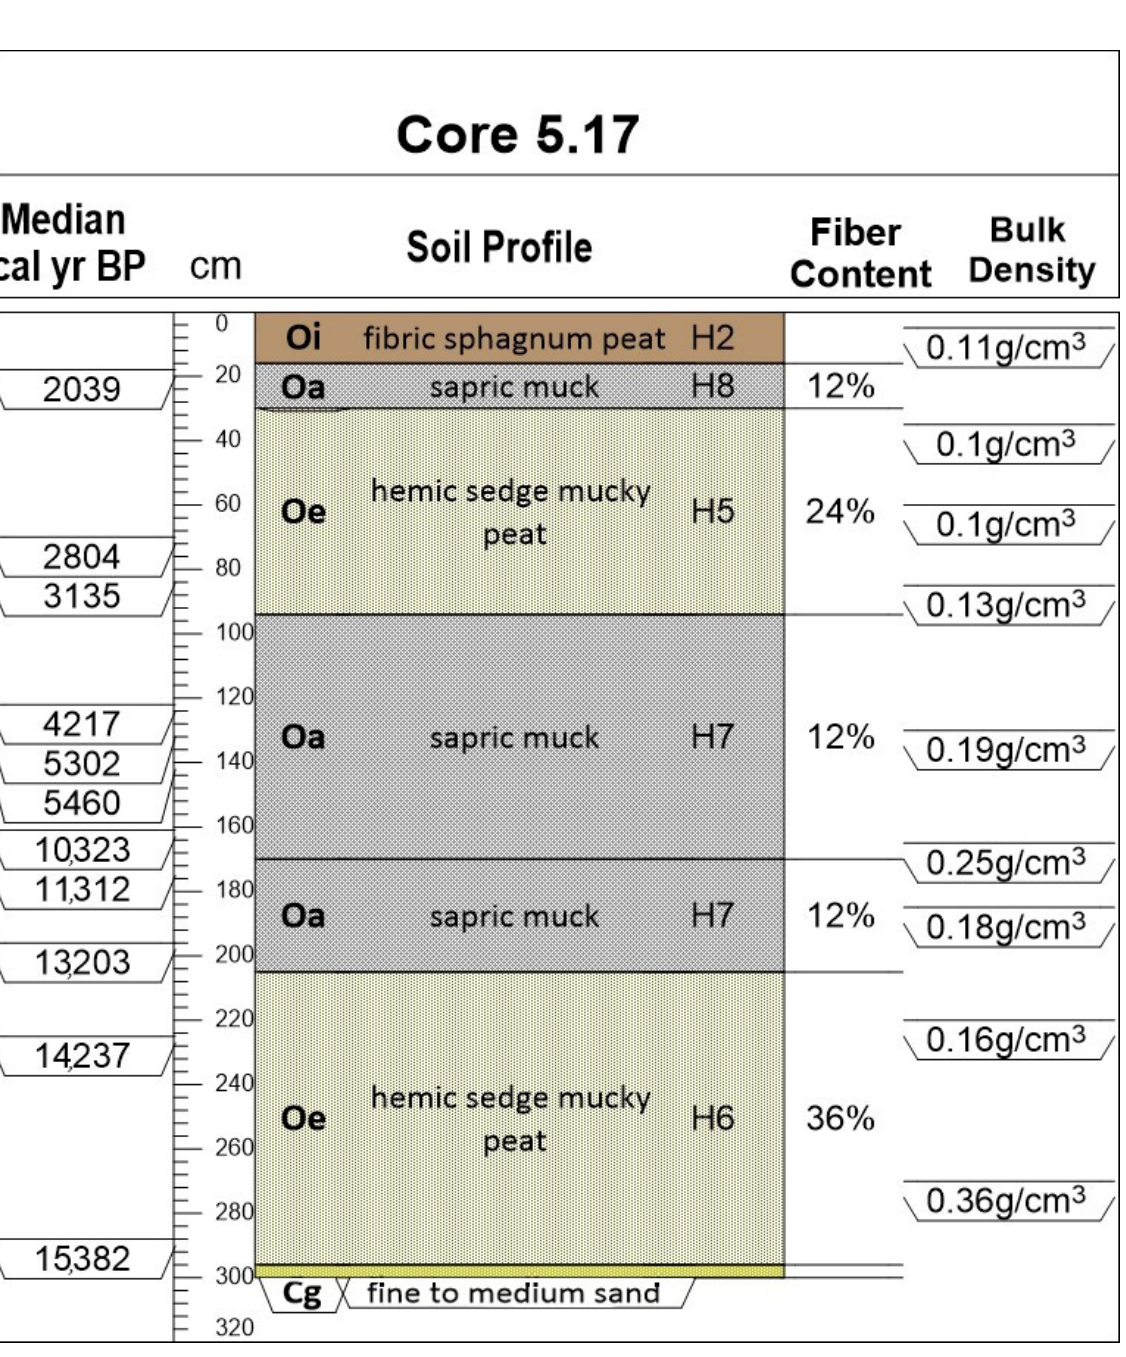
Figure 6. Soil profile of Core 5.17, representing Type C (HSH) profiles. Type D soil profiles (Figure 7) had a catotelm comprised entirely of sapric soil horizons (S). This horizonation occurred in four of the five peatlands (Table 2 and Figure 2). Most Type D (S) soil profiles occurred along the periphery of the shallow peatlands. None of these 11 soil profiles had laboratory data or radiocarbon